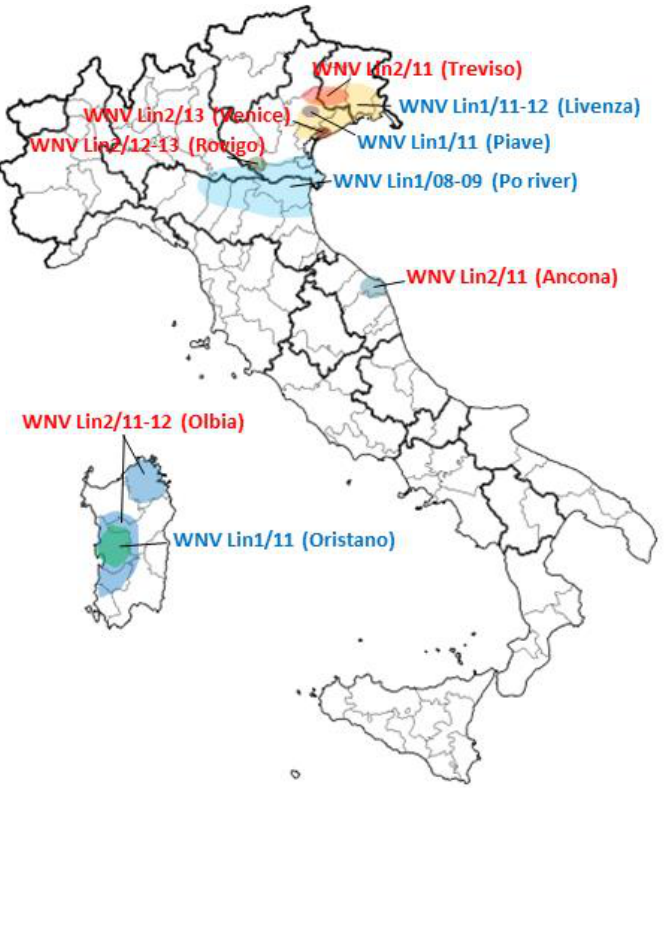
Figure 2. Map of Italy showing the areas where different WNV strains were detected in the period from September 2008 to August 2013. WNV lineage 1 strains are indicated in blue; WNV lineage 2 strains are indicated in